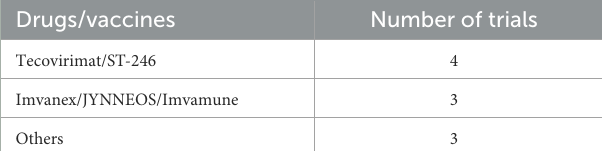
TABLE 2 Most studied drugs in clinical